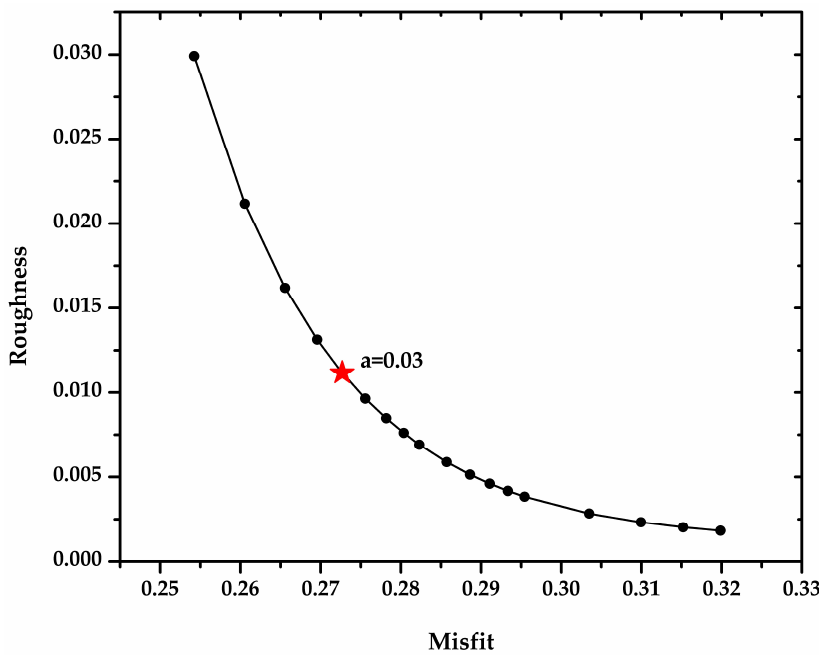
Figure 7. Curve representing the tradeoff between the model roughness and misfit. The red star indicates the location of the optimal smoothing